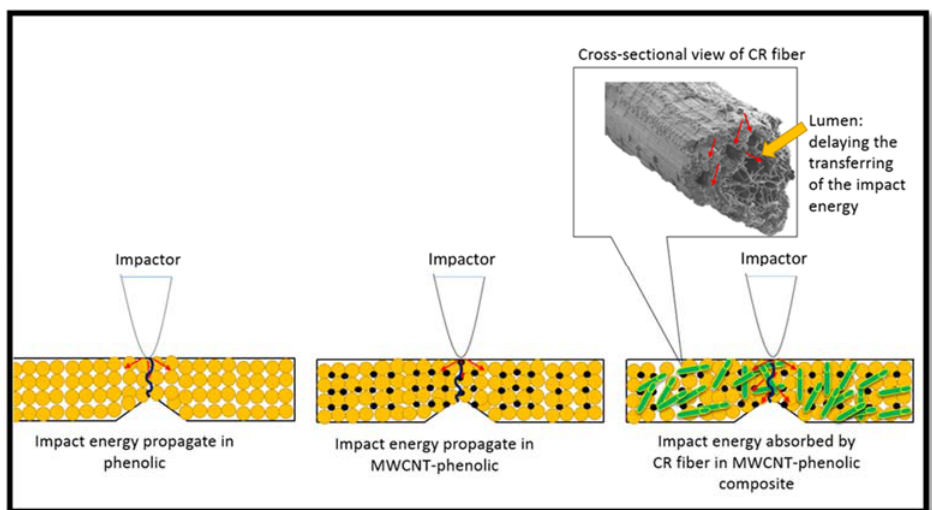
Figure 11. Schematic diagram of the impact energy propagation in CR fiber ‐ reinforced MWCNT ‐ Phenolic composites .